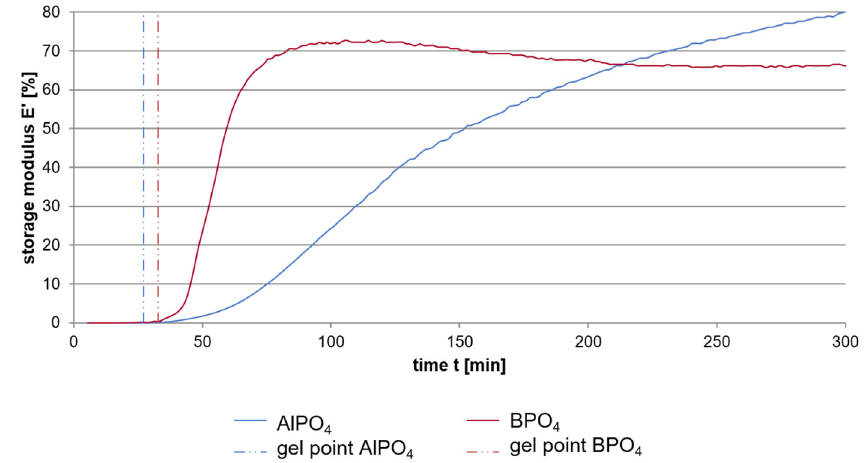
Figure 6. DMA measurements of a sodium water glass hardened with either AlPO 4 or BPO 4